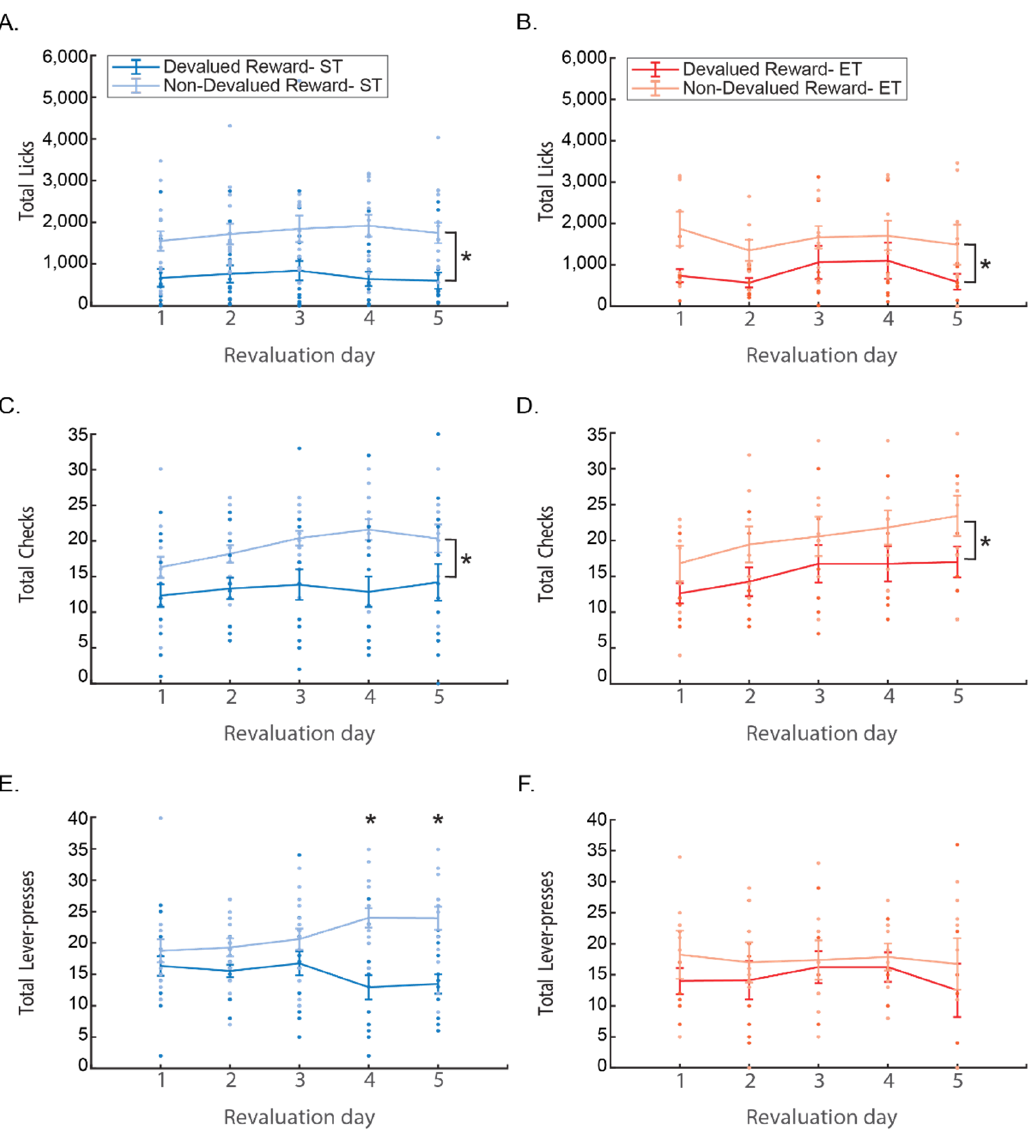
Figure 4. The task behaviors in the revaluation training. All following figures are line plots with error bars (standard error) overlaid with the dots of raw data of each mouse. Asterisk represents significance of p < 0.05. Blue (left figures A , C , E ) represents the short training group (ST) and red (right figures B , D , F ) represents the extended training group (ET). In each group, the lighter color represents the non-devalued reward and the darker color—the devalued reward; ( A , B ) presents the total number of licks; ( C , D ) presents the number of magazine checks; ( E , F ) presents the number of lever presses. Here, also, the instrumental lever press behavior was different than both licking and checking. Comparing the number of lever presses of the ST mice during the five days of revaluation training using a repeated two-way ANOVA with days and reward (devalued/non-devalued) as factors revealed a main effect of reward type (F(1, 14) = 9.6156, p < 0.01), with overall more lever presses to the non-devalued reward. While no main effect was found for days ( p > 0.1 n.s.), there was a significant days * reward interaction effect (F(4, 56) = 4.3003, p < 0.005), with Tukey Post hoc test showing that the difference